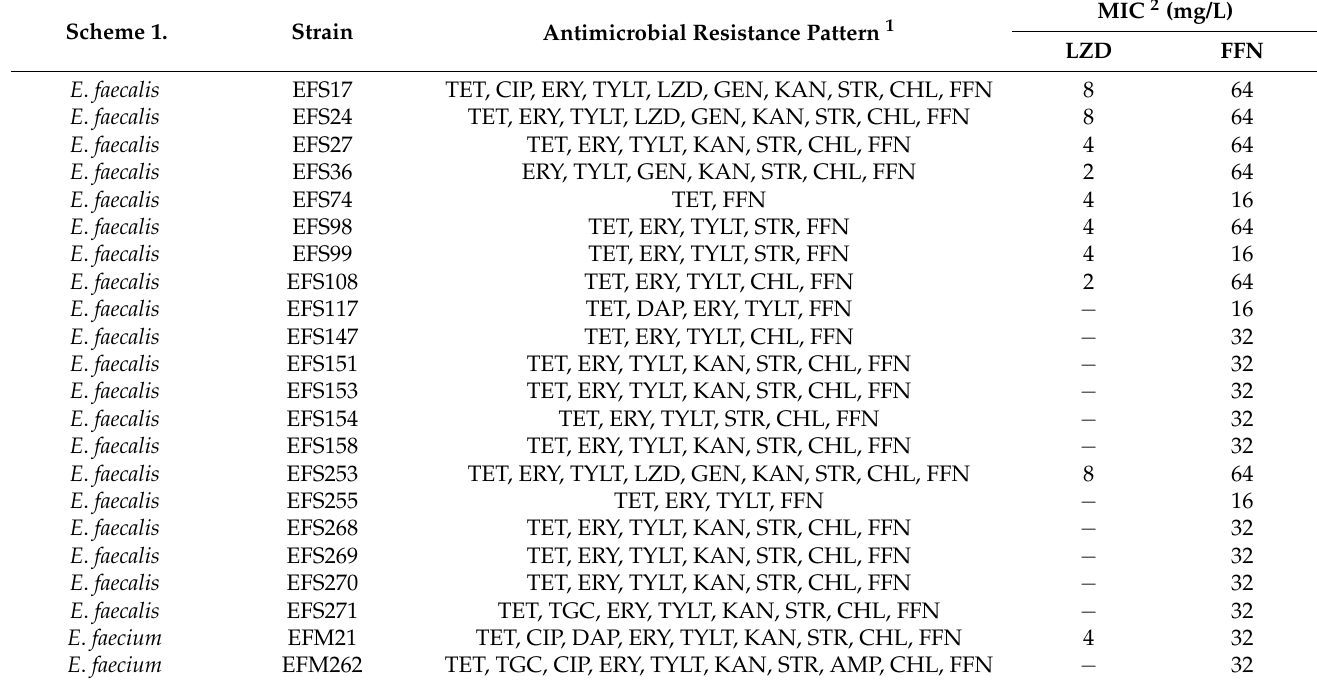
Table 2. Antimicrobial resistance patterns of enterococci strains harboring phenicol-oxazolidinone resistance genes. Scheme 1.